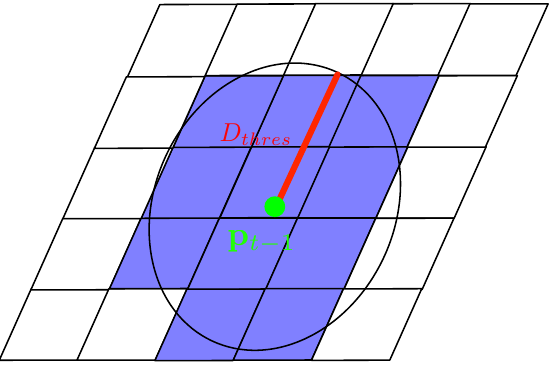
Figure 4. The grids within a certain distance threshold D thres to the previously estimated position p t − 1 is extracted as the sub-RFM (shown on horizontal